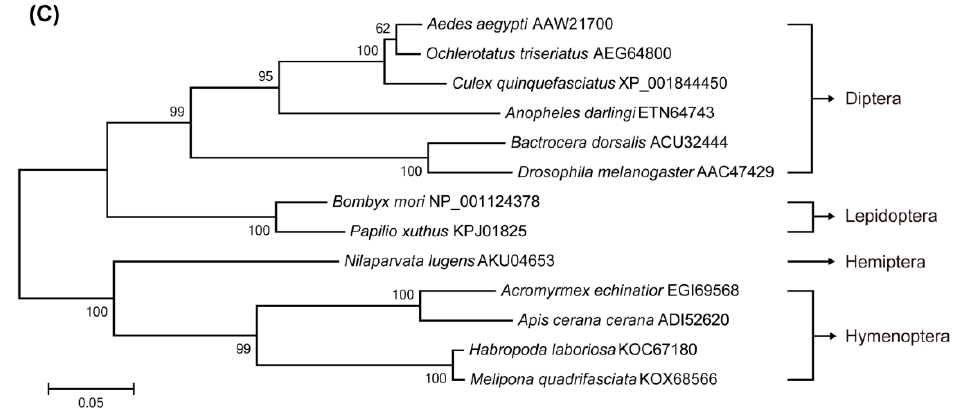
Figure 1. Phylogenetic analysis of Rheb ( A ), target of rapamycin (TOR) ( B ) and S6K (S6 kinase) ( C ) in insects. The tree was constructed by MEGA6 with the Maximum Likelihood method based on the amino acid sequences alignment [30]. Bootstrap test with 1000 replicates was used to analyze the evolutionary relationship and bootstrap values were shown in the cladogram. The scale bar indicates genetic distance.